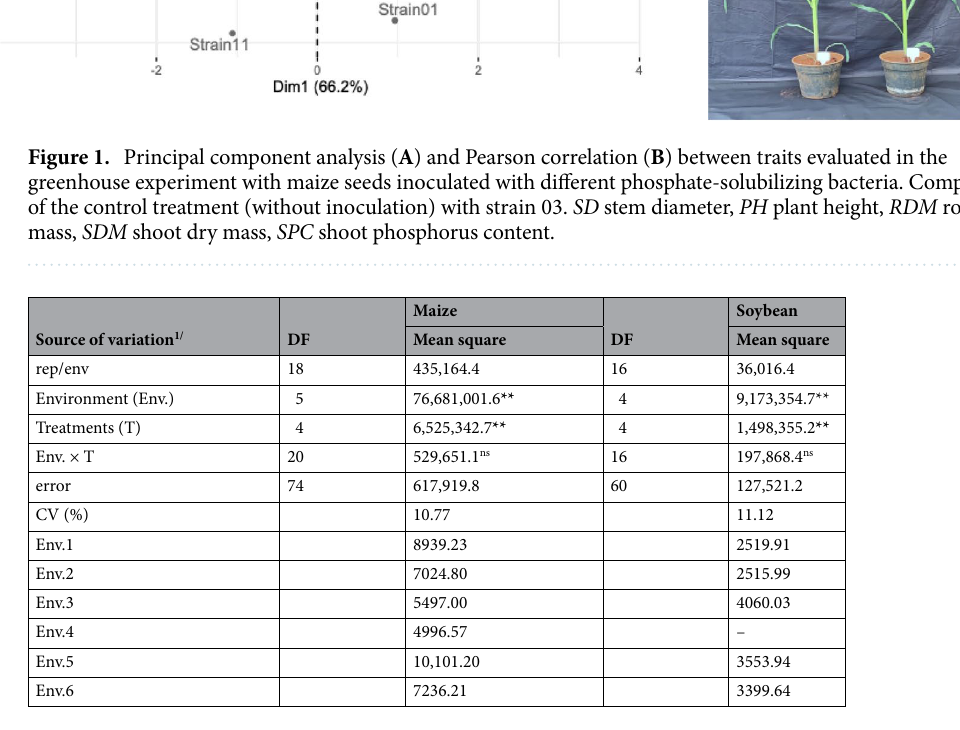
Table 1. Analysis of variance for grain yield in maize and soybean experiments with seeds inoculated with phosphate-solubilizing bacteria. 1/ Env1.: Londrina (2020/2021), Env2.: Maringá (2020/2021), Env3.: Guarapuava (2020/2021), Env4.: Londrina (2021/2021), Env5.: Londrina (2021/2022) and Env6.: Guarapuava (2021/2022). ns , ** and * indicates non-significance, significance at levels 1 and 5% of probability by the F test,